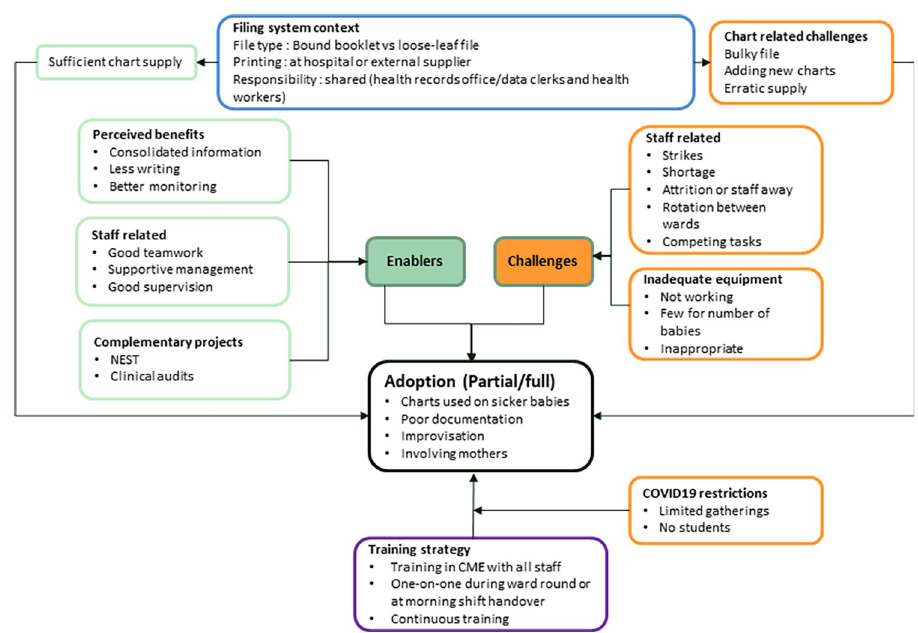
Fig 2. Summary of enablers, challenges and context leading to chart